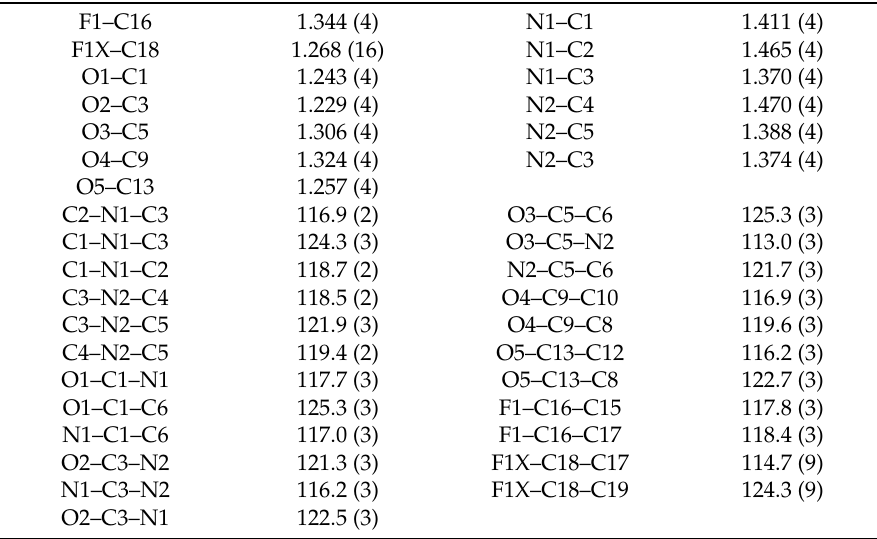
Table 2. Selected geometric parameters (Å, ◦ ).